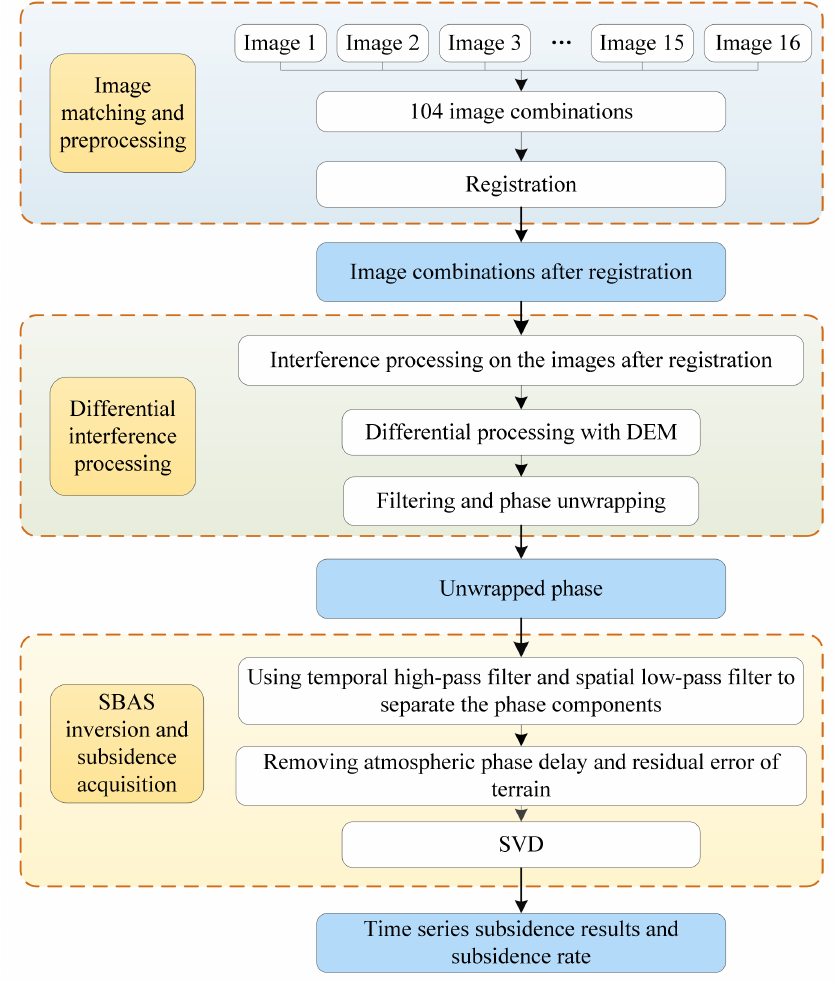
Figure 3. Data processing by